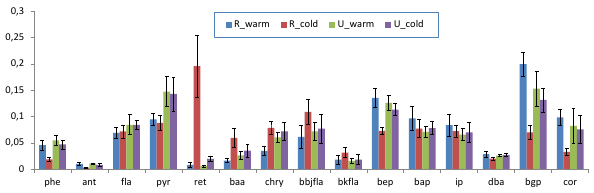
Figure 2. Relative composition of PAHs to P PAH for the different period (warm vs. cold) in the rural (R) and urban (U) sites.